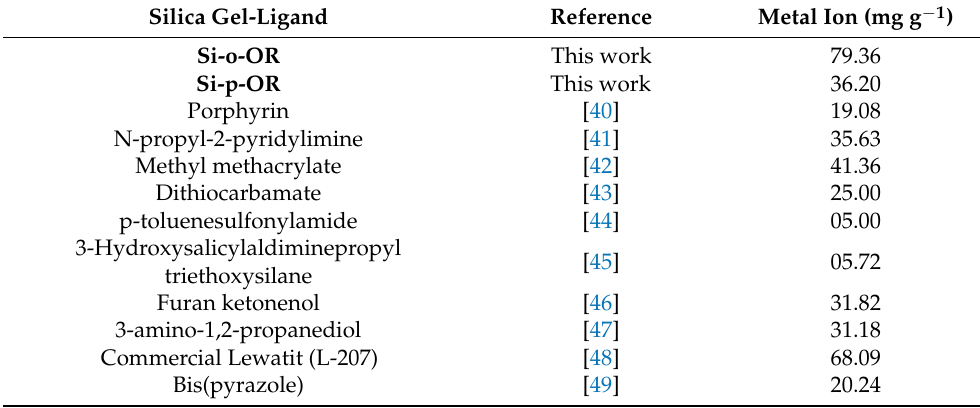
Table 7. Comparison of the maximum adsorption capacities of Cu(II) by different adsorbents reported in the